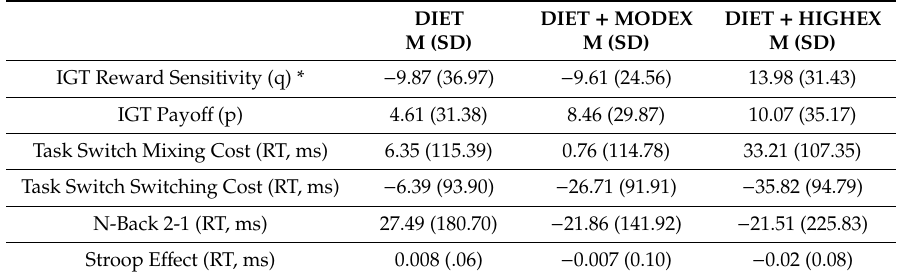
Table 2. Cognitive change scores by intervention group. Indicators of significant di ff erences were adjusted for age, sex, and racial